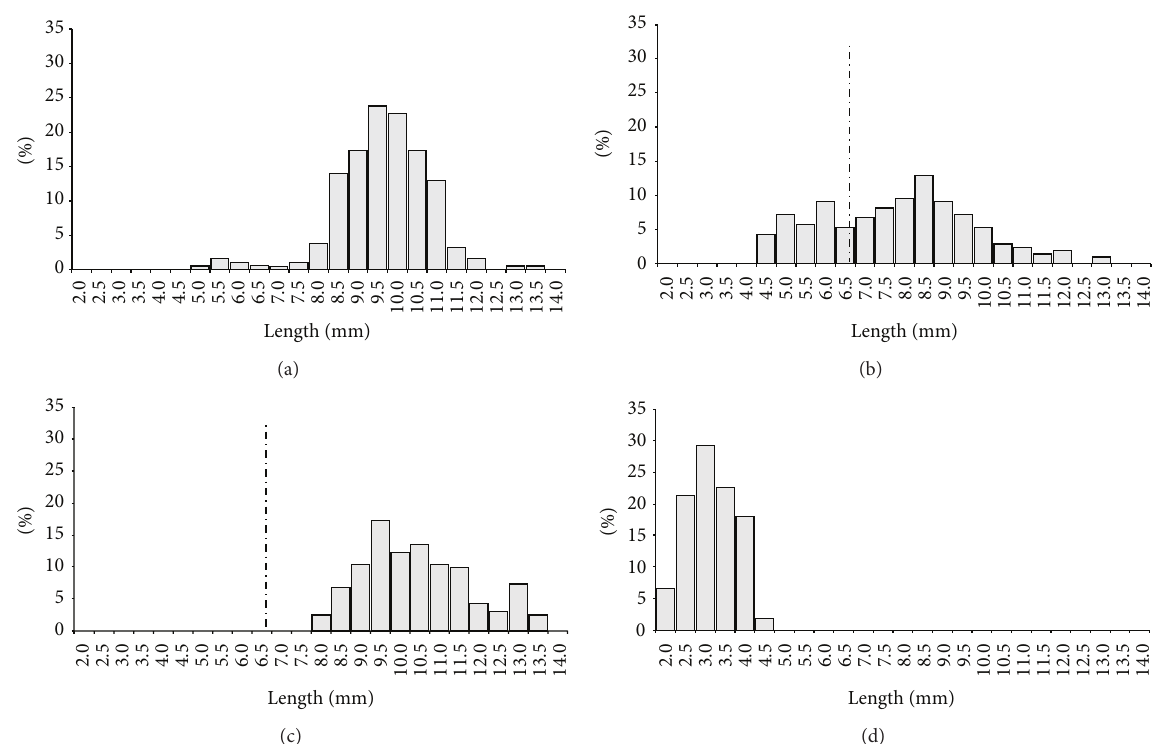
Figure 6: Distribution of frequency by class of length of Monokalliapseudes schubarti in Saco da Fazenda, during the period from July 2003 to June 2004: (a) males; (b) females ∗ ; (c) ovigerous females ∗ ; (d) juveniles ( 𝑛 = 220 ; ∗ traces line = size of first mature stage, according to Fonseca and D’Incao [16]).